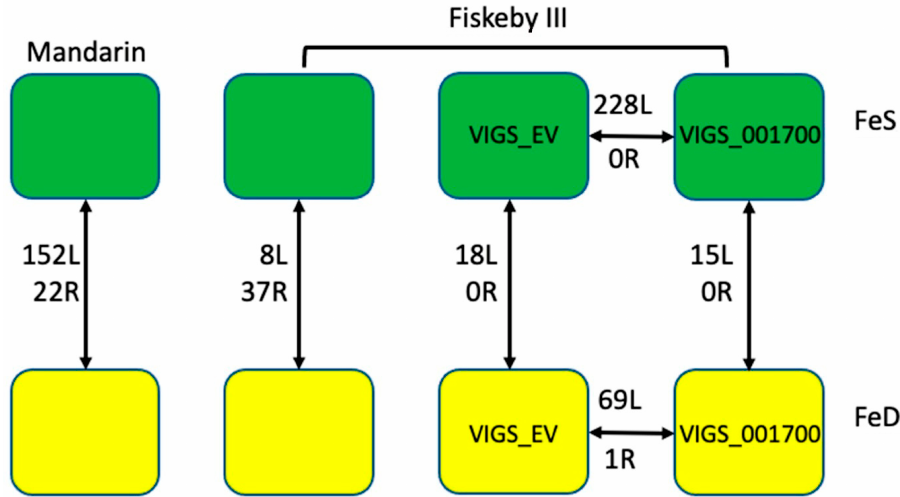
Figure 4. Experimental Design. Green represents iron sufficient (FeS, 100 µ M Fe(NO 3 ) 3 ). Yellow represents iron deficiency (FeD, 50 µ M Fe(NO 3 ) 3 ). Only one set of Mandarin (Ottawa) plants was included in this experiment. These were not inoculated with any VIGS construct. Plants inoculated with VIGS_Glyma.05G001700 are denoted as VIGS_001700. Results from edgeR DEG analyses (required to have FDR < 0.01) are indicated by numbers followed by either an L (leaf) or R (root), to indicate the tissue analyzed.